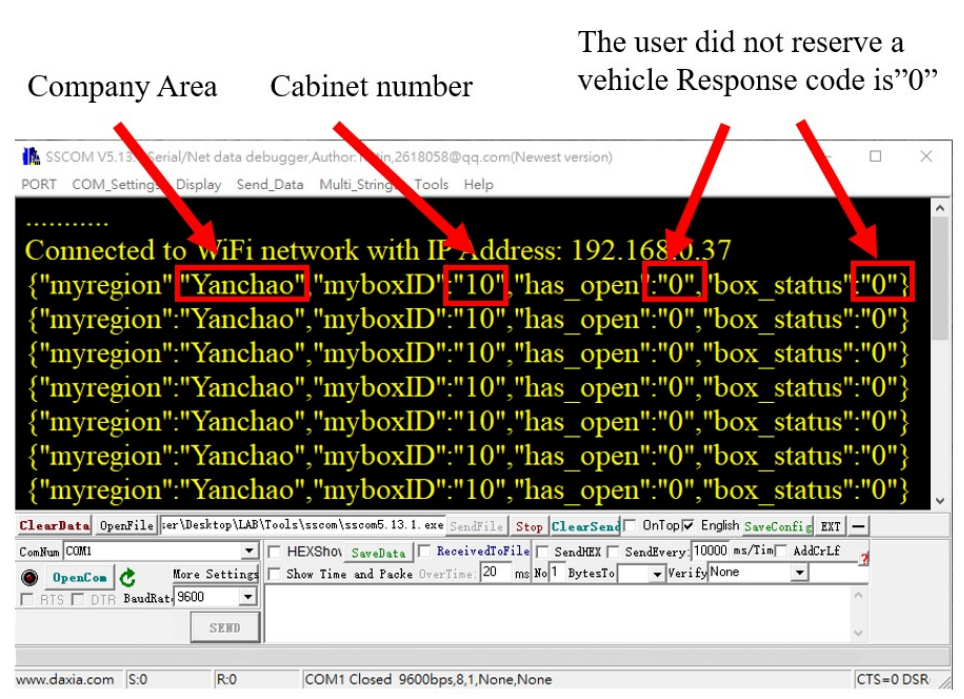
Figure 24. SSCOM read and return data diagram (for not using a vehicle).